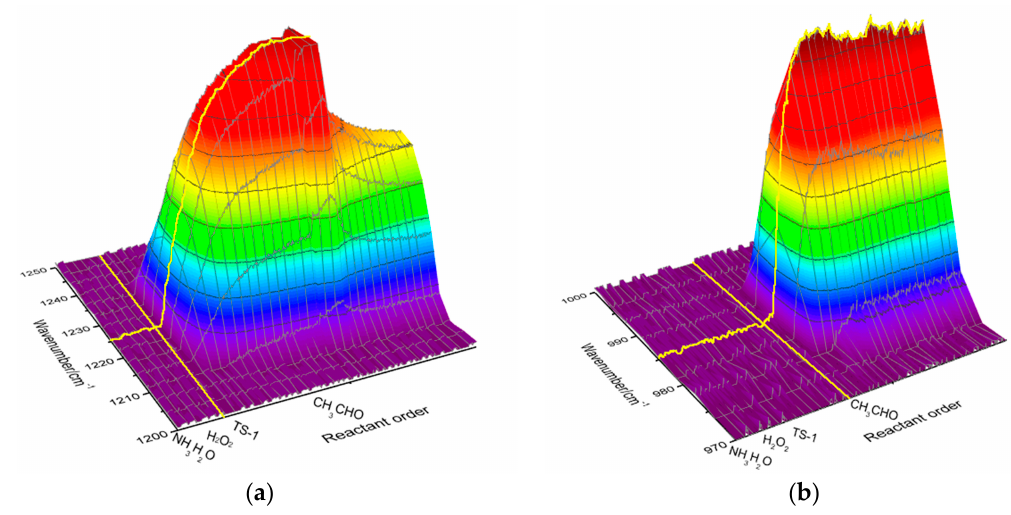
Figure 2. With the reactants added in the same order, ( a ) peak curve at 1227 cm − 1 and ( b ) Peak curve at 985 cm − 1 began to change in a different pattern.